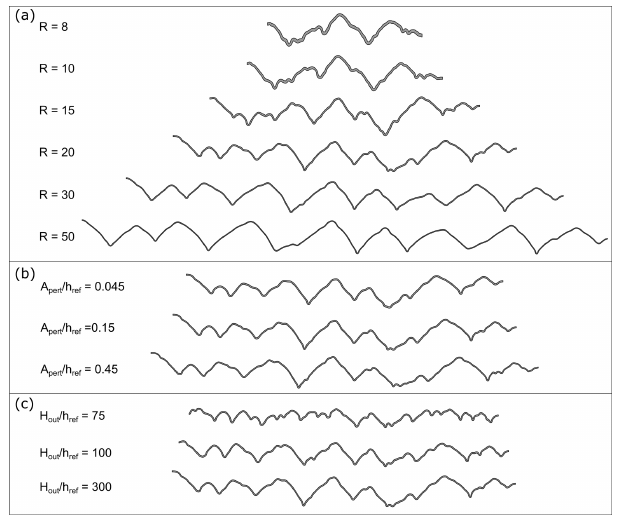
Figure 14. Fold shape of the uppermost layer in the D2 domain for (a) different viscosity ratios, R (set 1), (b) different initial nor- malised perturbation amplitude, A pert /h ref , (set 2), and (c) different initial normalised thickness of the outer layers, H out /h ref (set